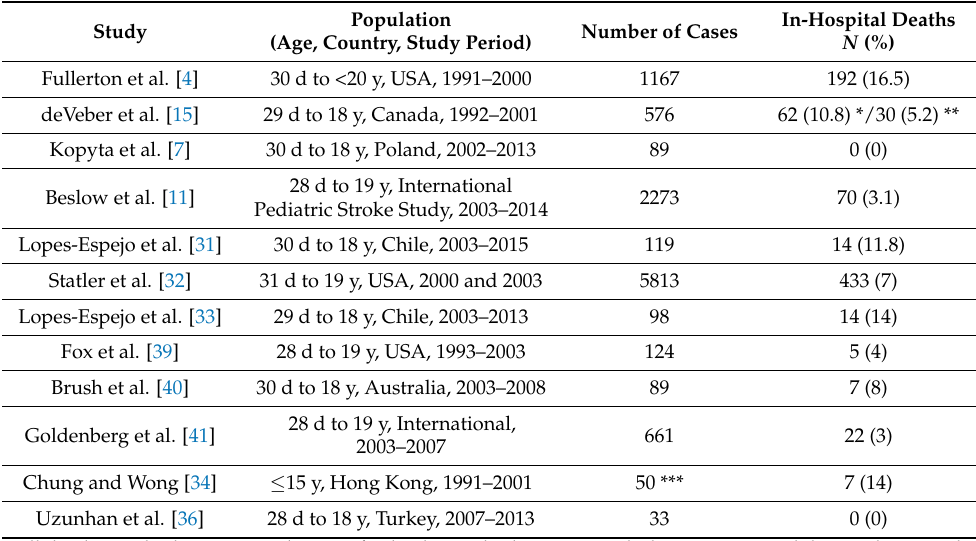
Table 2. Prevalence of stroke mortality in pediatric AIS